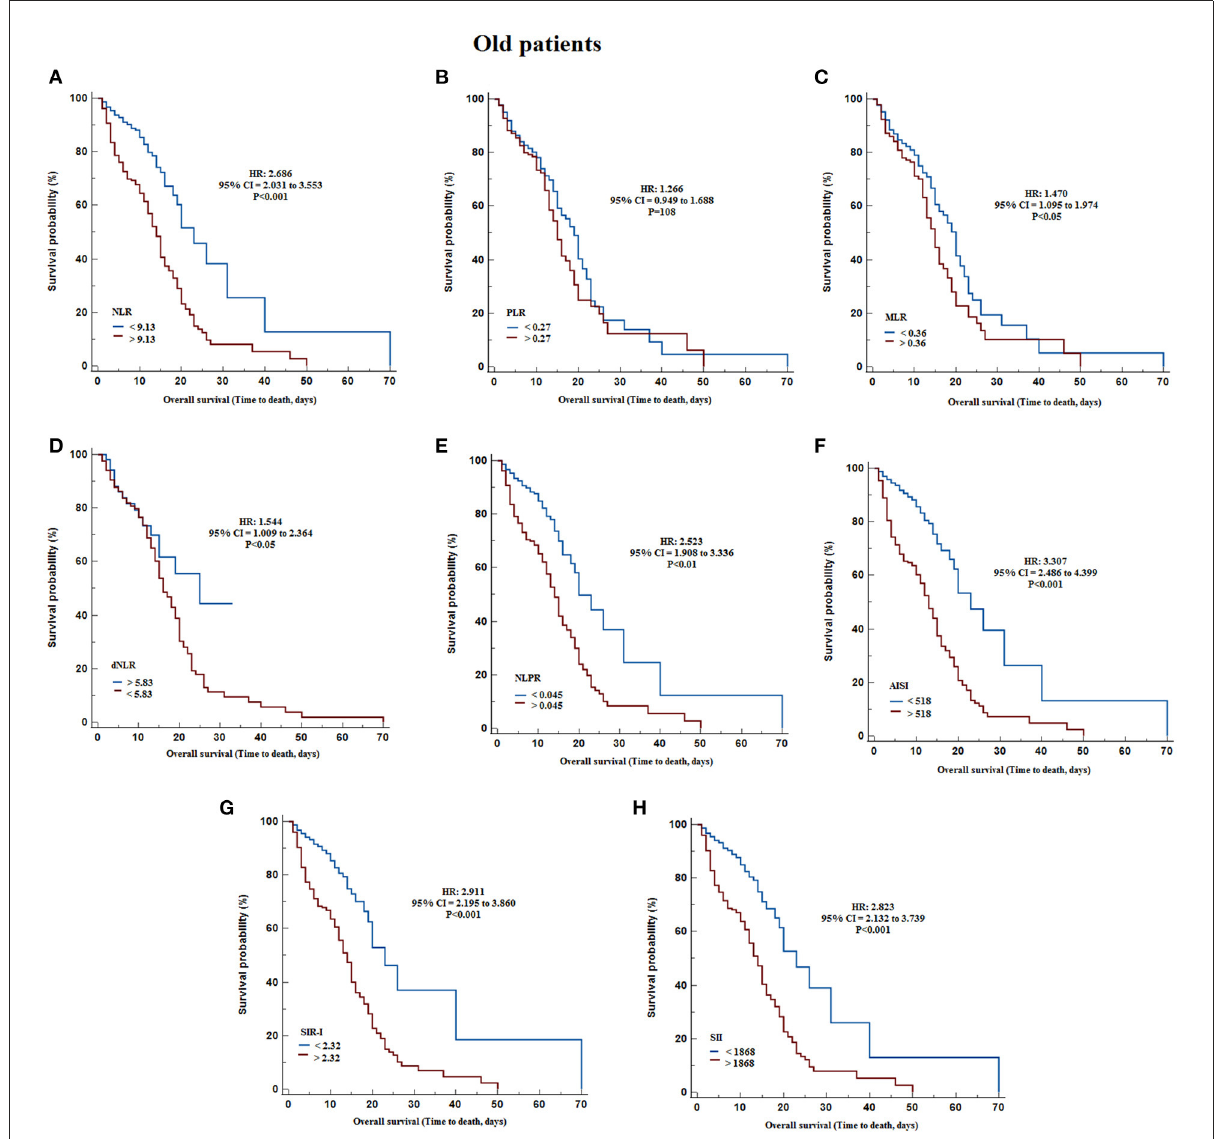
FIGURE3 Kaplan–Meier survival curves during hospitalization of elderly COVID-19 patients with different cut-off values of the systemic inflammation indexes investigated. (A) NLR; (B) PLR; (C) MLR; (D) dNLR; (E) NLPR; (F) AISI; (G) SIR-I; (H) SII. AISI, aggregate index of systemic inflammation; dNLR, derived neutrophil/lymphocyte ratio; MLR, monocyte/lymphocyte ratio; NLPR, neutrophil/lymphocyte*platelet ratio; NLR, neutrophil/lymphocyte ratio; PLR, platelet/lymphocyte ratio; SII, systemic inflammation index; SIR-I, systemic inflammation response